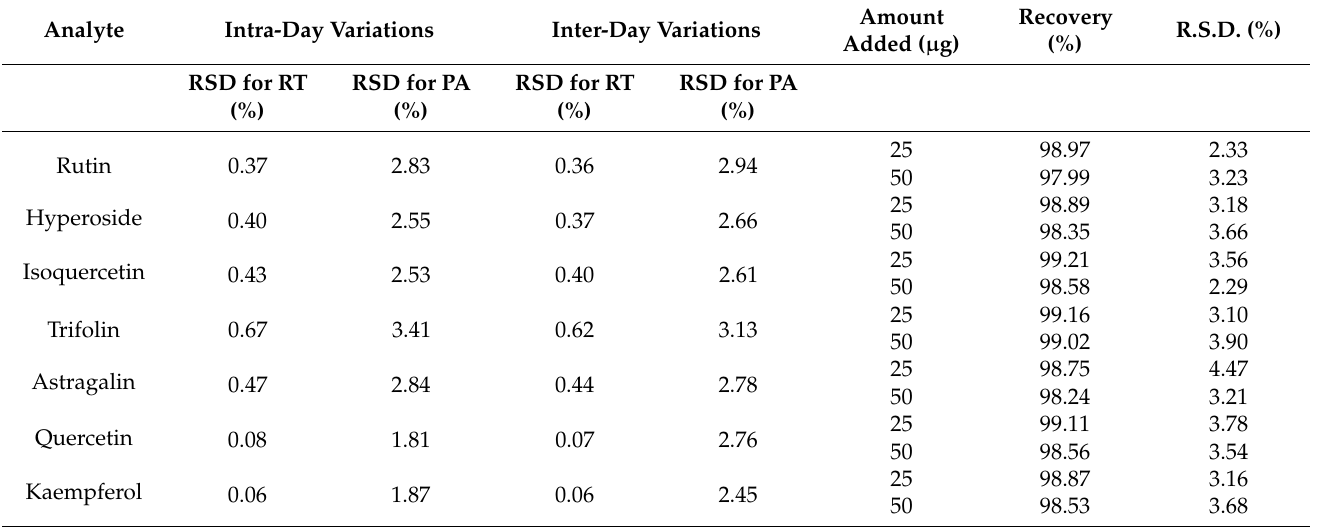
Table 4. Precision and recovery of seven flavonoids ( n =